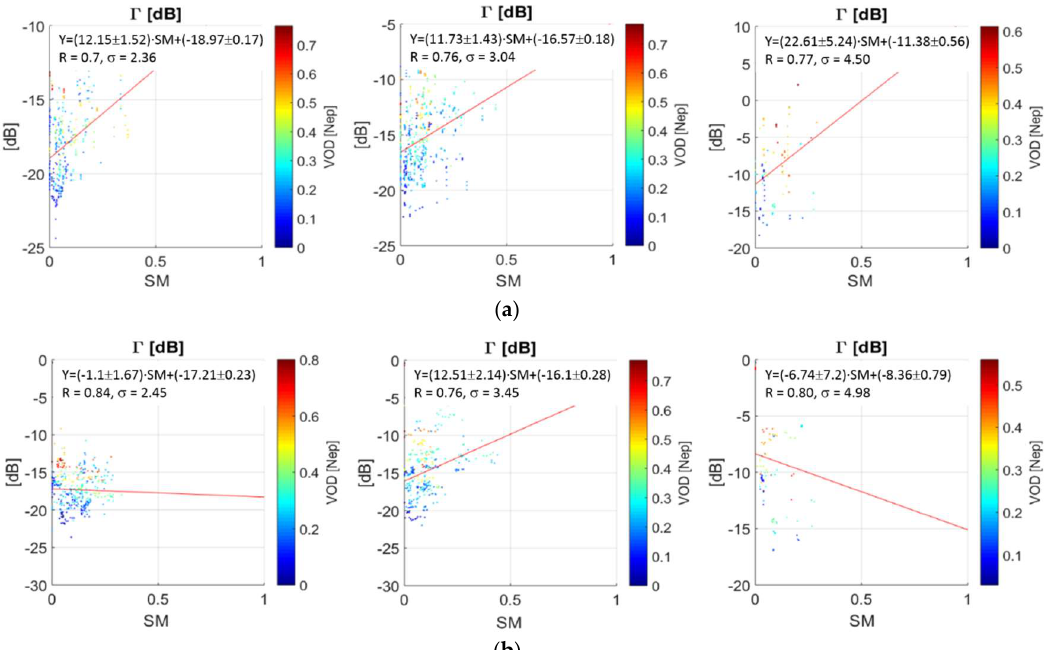
Figure 13. Scatter plot between the ( a ) Low Resolution (25 km) SMOS L3 SM and ( b ) High Resolution (1 km) SMOS L4 SM and the TDS-1 reflectivity value over the CEMADEM region from June 2016 to June 2017, with vegetation and roughness corrections applied. Each column represents the values for a specific range of incidence angles: ( left ) 0°–30°; ( center ) 30°–60°; and ( right ) 60°–90°.